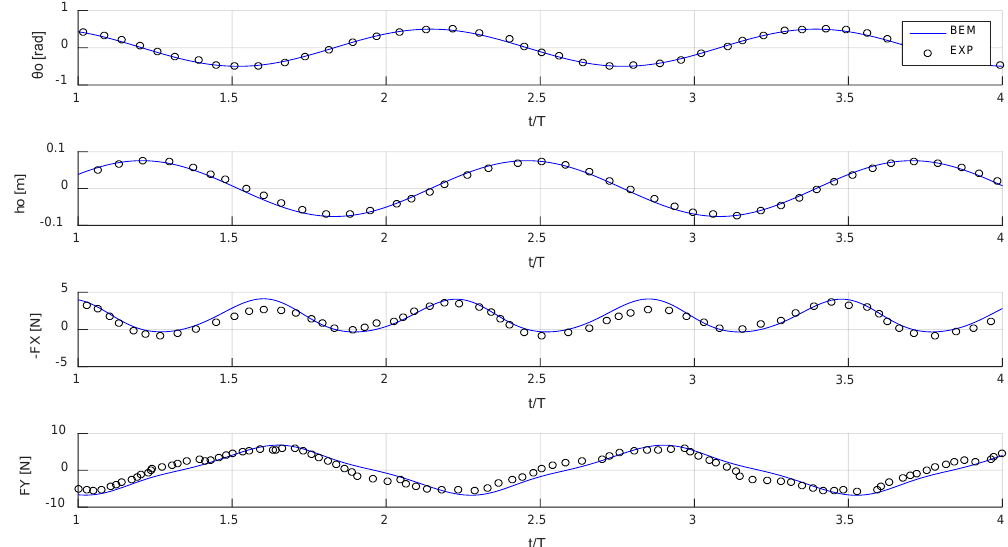
Figure 9. Time history of foil pitch and heave against thrust and lift forces for the chordwise rigid foil with simple harmonic motion and comparison with the experimental data from [32]. ( a ) Pitch angle, ( b ) Heave, ( c ) Horizontal force, ( d ) Vertical force of the foil.